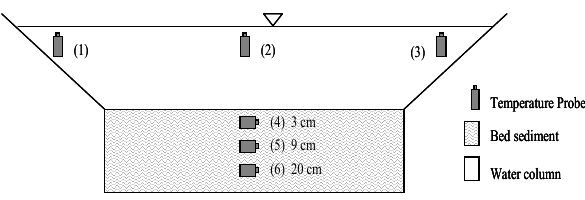
Fig. 2. Locations of temperature probes at Sites 2 and 3 within the study reach. (Taken directly from Neilson et al.,